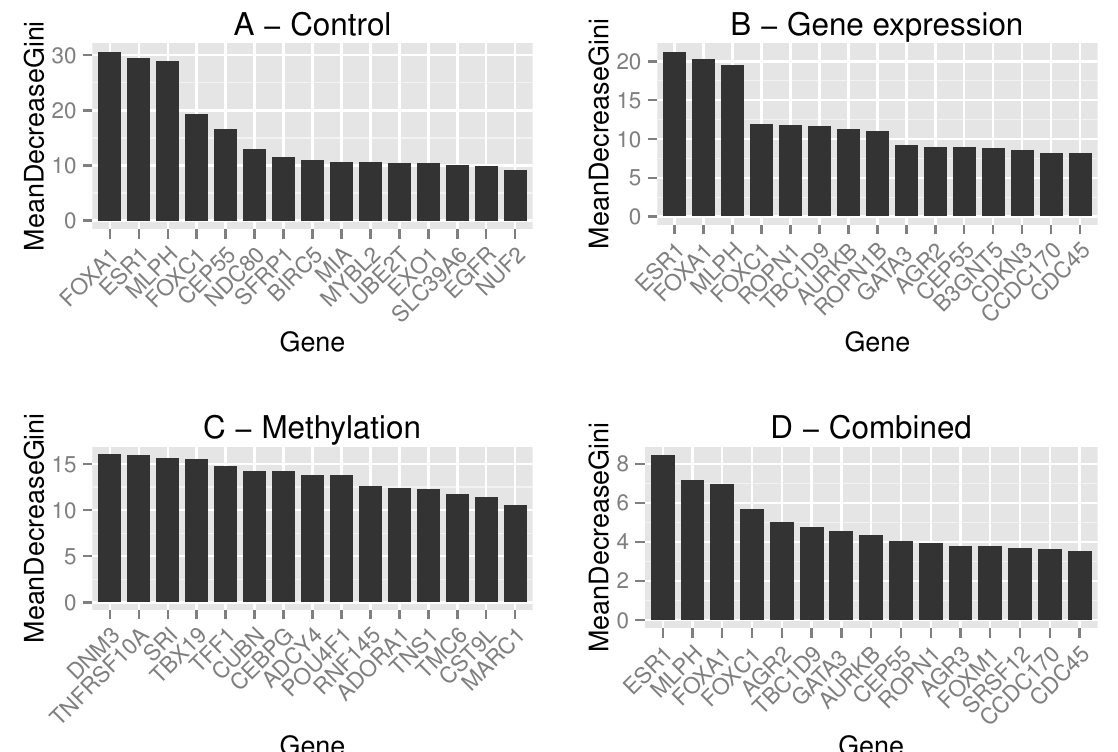
Figure 4: The 15 most important features determined by the mean decrease in gini index for models based on control model (A), gene expression model (B), methylation model (C) and combined model